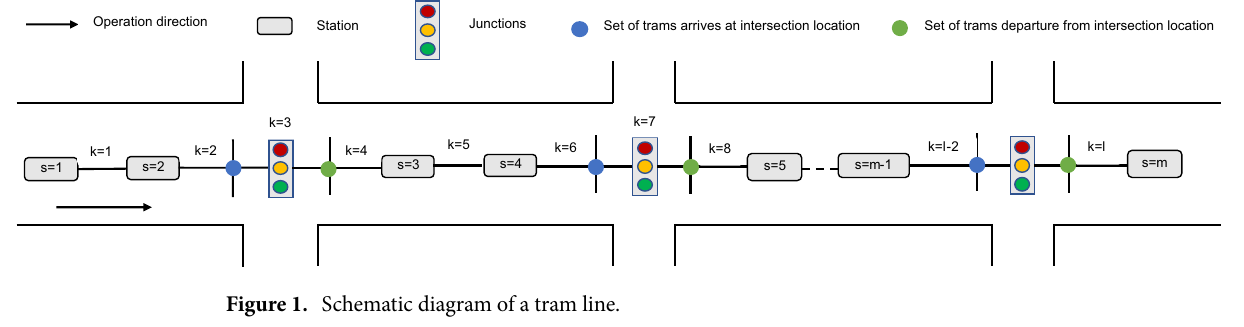
Figure 1. Schematic diagram of a tram